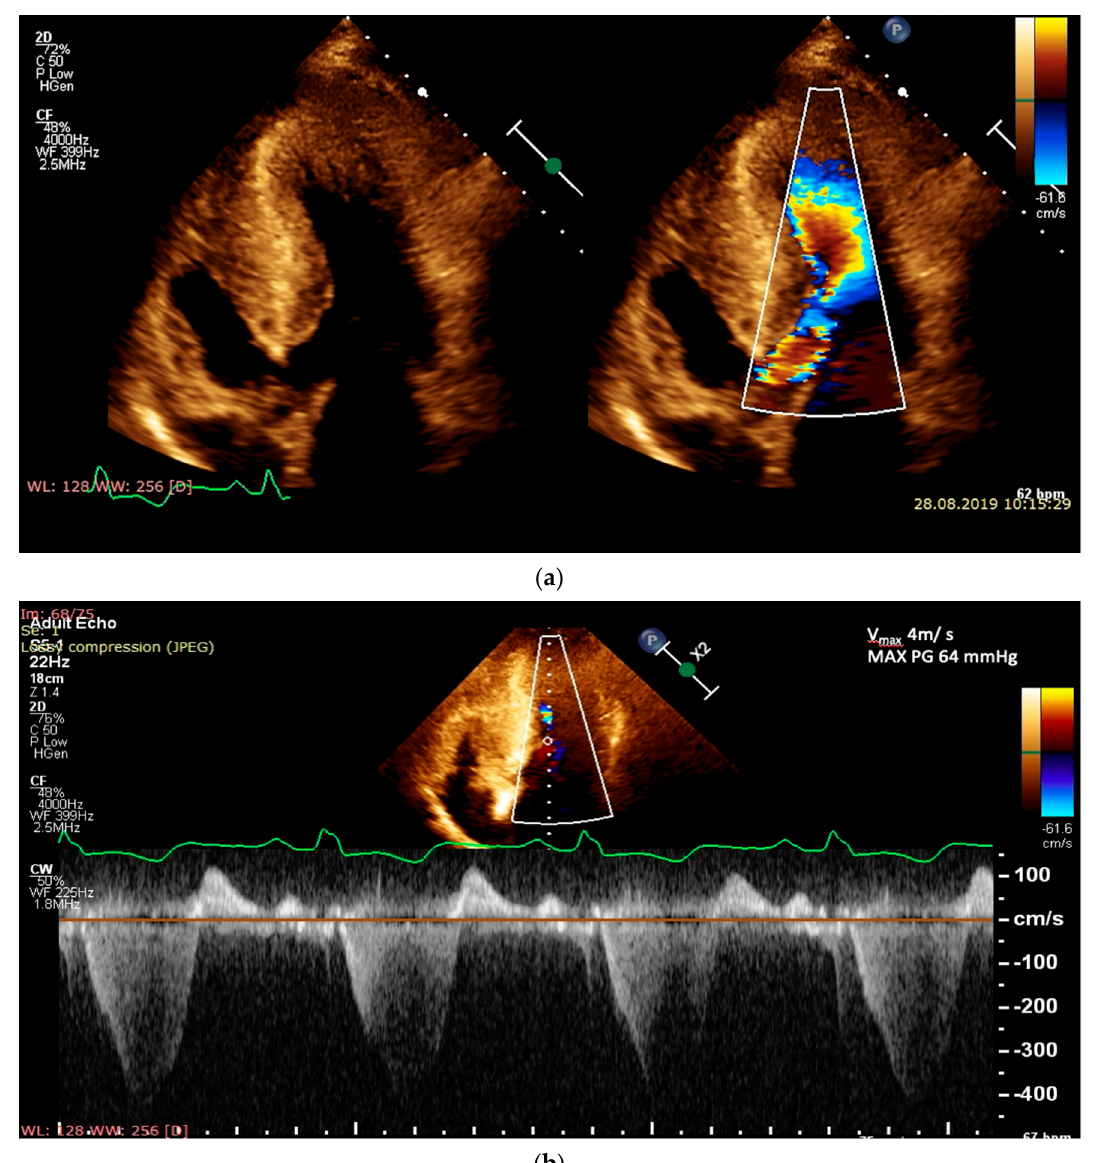
Figure 1. Echocardiography assessment at rest, in a 20-year-old male with obstructive hypertrophic cardiomyopathy: ( a ) apical five-chamber view with and without color Doppler demonstrating left ventricular mid-cavity and outflow tract obstruction, with turbulent flow; ( b ) continuous wave Doppler through the left ventricular outflow tract demonstrating the obstruction, with a peak gradient of 64 mmHg.